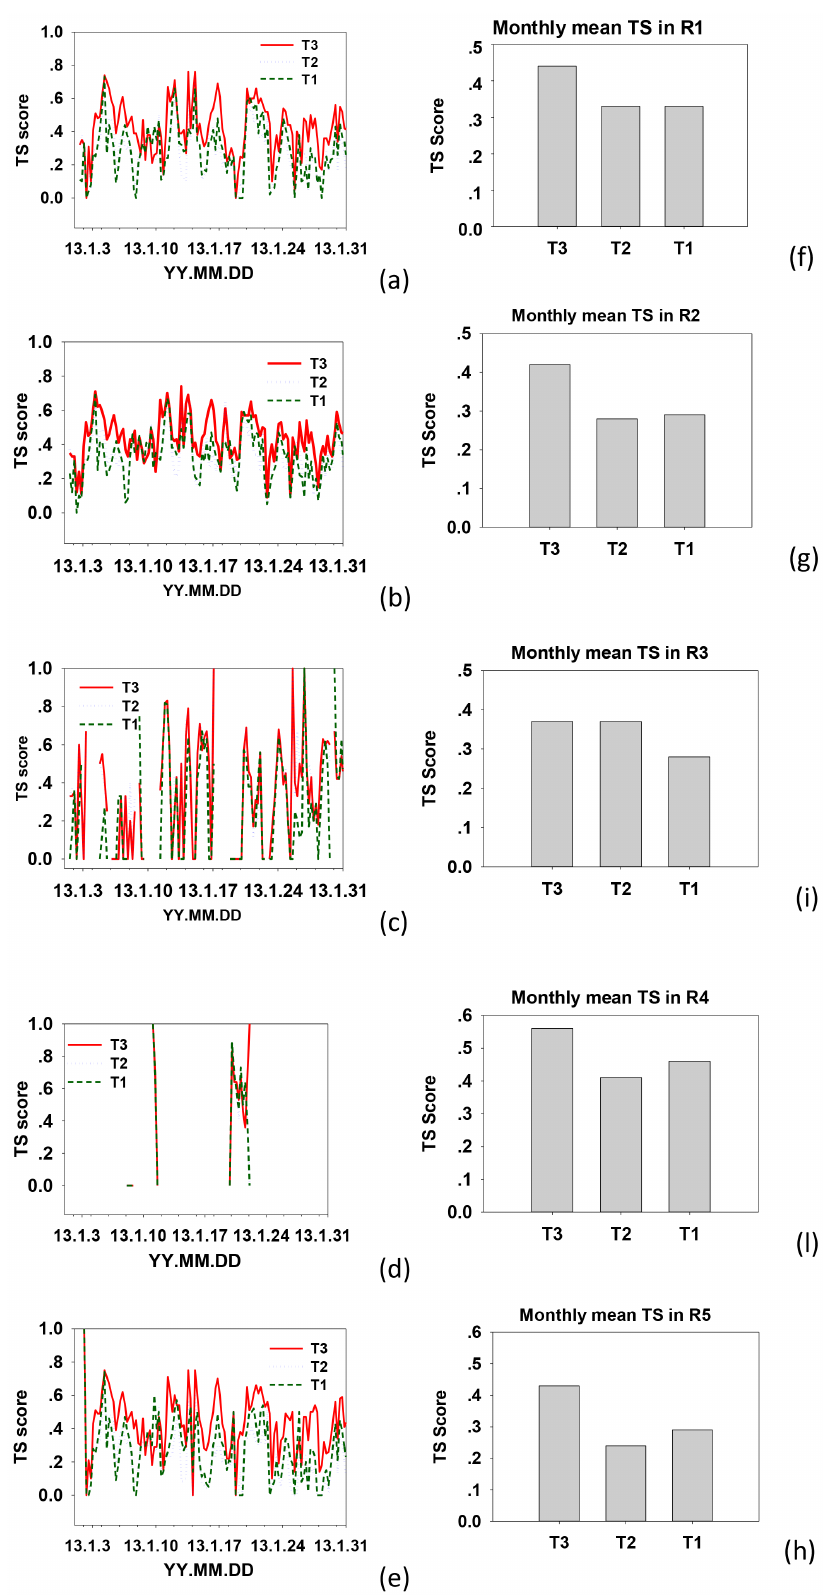
Figure 5. Time series of 6h precipitation threat scores (TS) (a – e) and monthly mean TS (f – h) for R1, R2, R3, R4, and R5. T1 denotes WSM6, the control test, T2 is the WDM6 with the K2000 activation scheme, and T3 denotes WDM6 with aerosol activated from